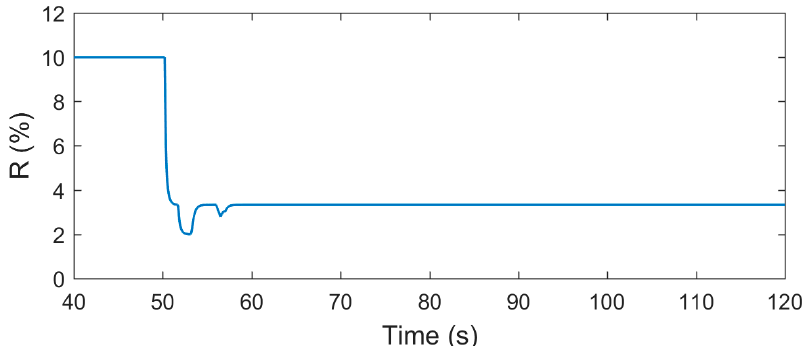
Figure 9. Dynamic droop (large ROCOF).